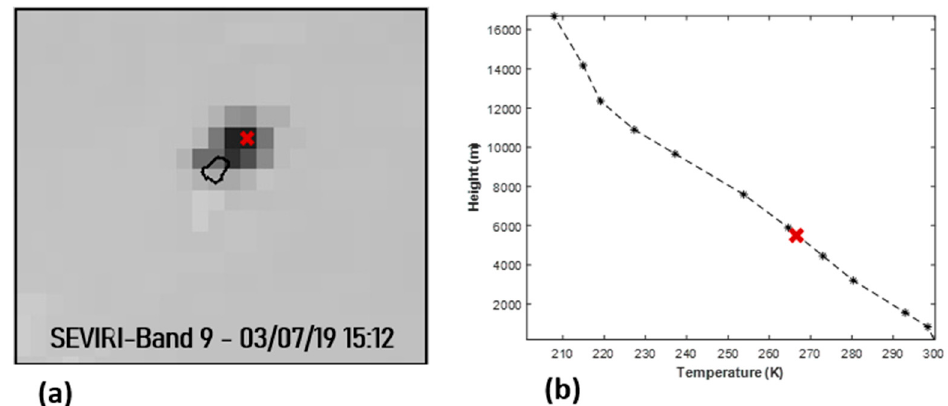
Figure 5. Plume Height retrieved by using SEVIRI Band 9 image of 3 July 2019 15:12 UTC ( a ) and the atmospheric profile from NCAR/NCEP for 3 July 2019 at 12:00 UTC ( b ). The red x indicates the value corresponding to the minimum pixel value of the BT image in ( a ) and the corresponding retrieved height value in ( b